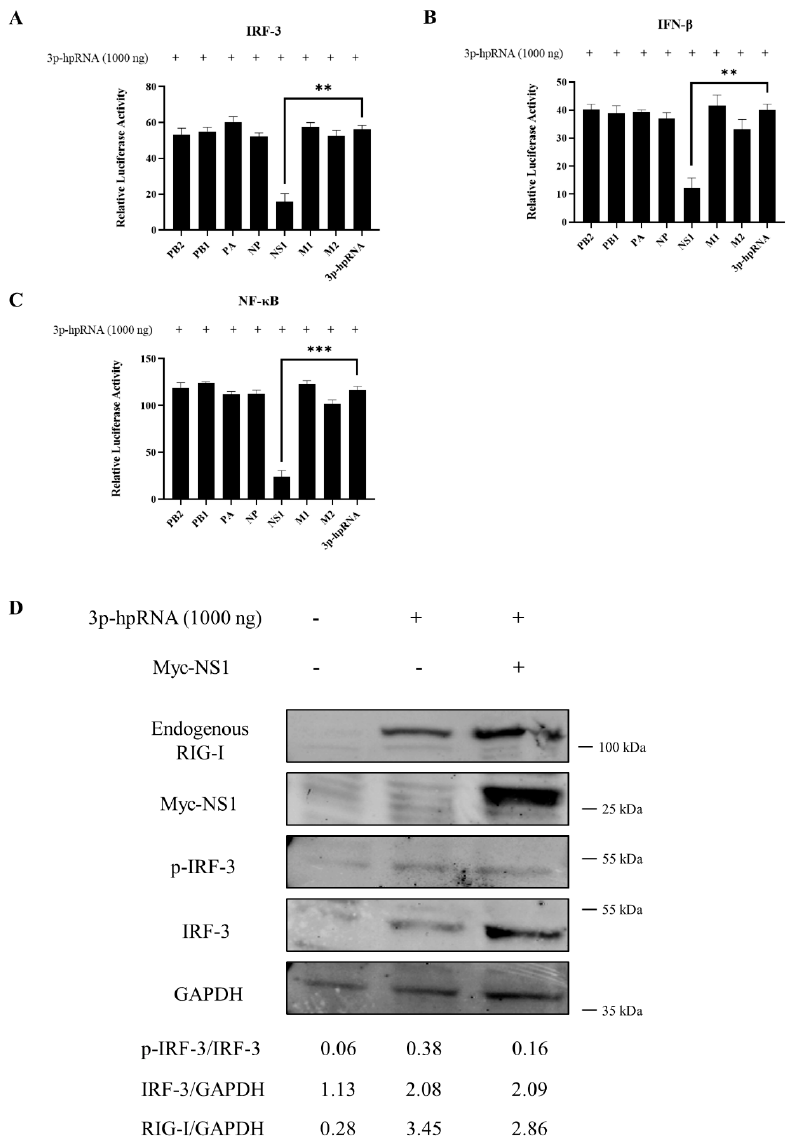
Figure 6. CIV NS1 impairs activation of RLR signaling in MDCK cells. ( A ) IRF-3 ( B ) IFN- β , and ( C ) NF- κ B, promoter activity in the cells was evaluated 24 h after transfection with Myc-tagged CIV viral protein along with the 1000 ng RIG-I agonist 3p-hpRNA. Samples were analyzed in triplicate and three independent experiments were performed. ** p < 0.01, *** p < 0.001 vs empty vector control group. Error bars indicate standard deviation. ( D ) MDCK cells were transfected with 1000 ng RIG-I agonist 3p-hpRNA along with or without Myc-NS1 plasmid; the whole cells protein was obtained for western blotting. Protein band intensity of endogenous RIG-I, IRF-3 and phosphorylated IRF-3 were used for western blotting quantification analysis.